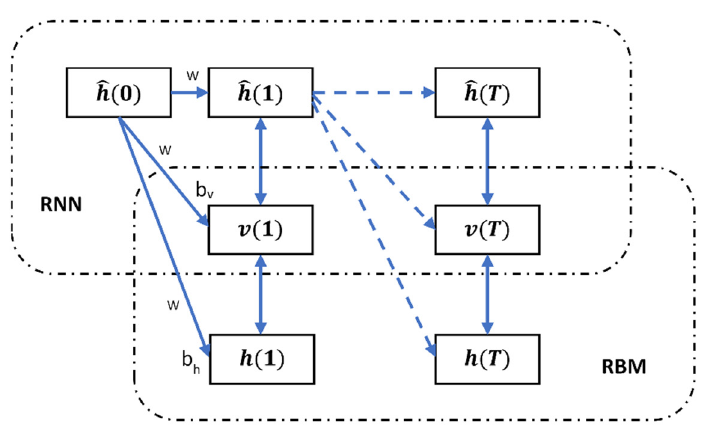
Figure 3. The structure of RNN-RBM. The hidden units of RNN layers at time t are connected to each other in chain configu- ration and connected with visible layers of RBM as shown in Equation (12)